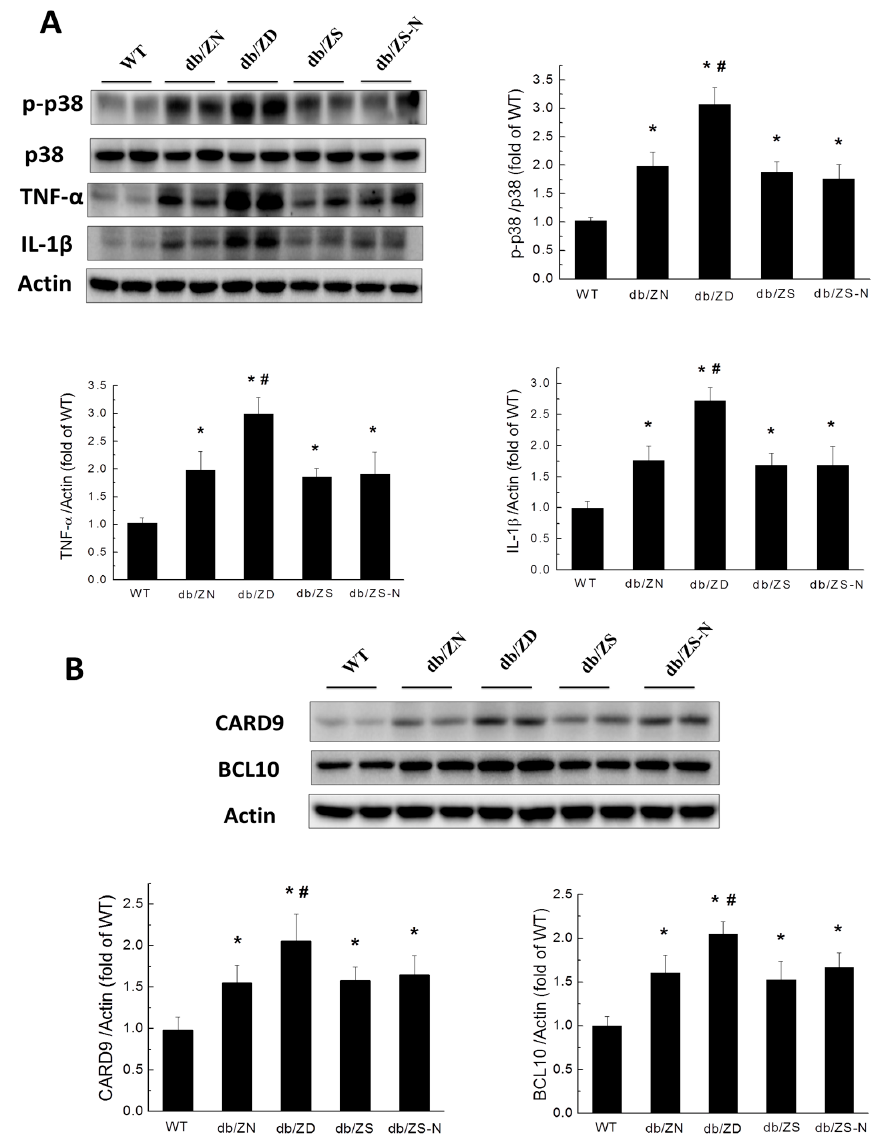
Figure 4. Zn deficiency exacerbates diabetes ‐ induced cardiac inflammation. Western blot was used to assess fibrosis ‐ related factors such as p ‐ P38/p38, TNF ‐α , IL ‐ 1 β ( A ), CARD9, and BCL10 ( B ). Data were